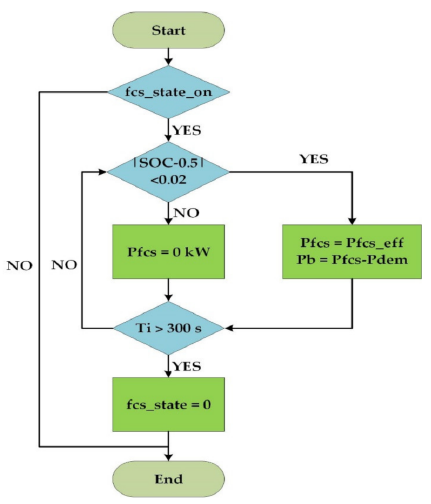
Figure 8. Flowchart of rule-based control strategy in idle